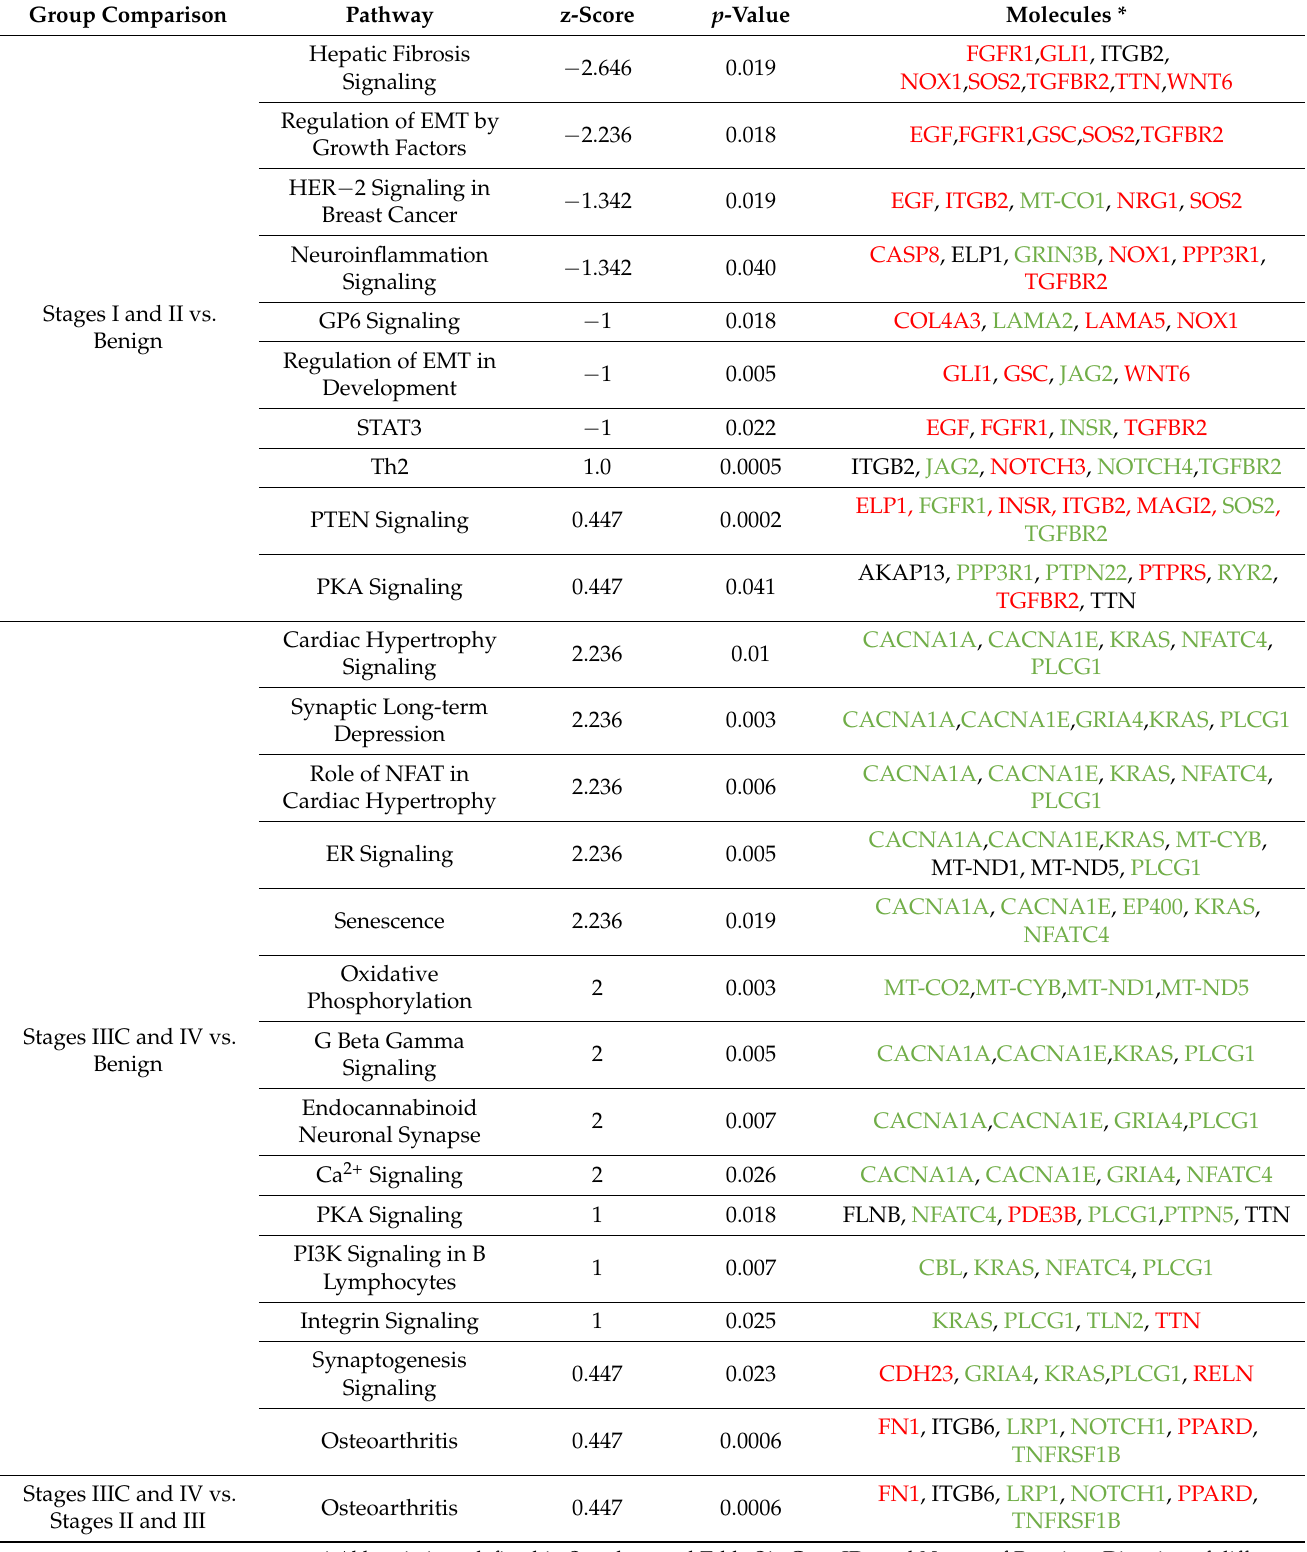
* Abbreviations defined in Supplemental Table S1: Gene IDs and Names of Proteins. Direction of difference between first and second group listed in agreement with pathway activation (green) or repression (red), or no anticipated direction of difference